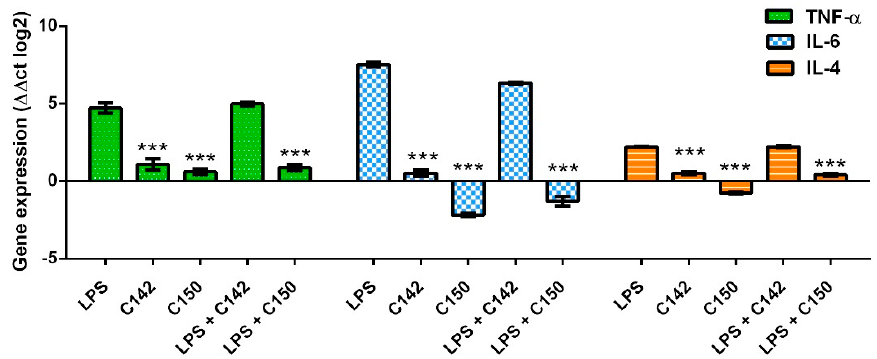
Figure 8. C150 inhibits the expression of tumor necrosis factor (TNF)- α , interleukin (IL)-6, and IL-4 upon LPS induction of human peripheral blood mononuclear cells (PBMCs) as described in Section 4.8 of Materials and Methods. Results are shown as mean ± S.E.M.; *** p < 0.001 pair-wise comparison with LPS-treated group.